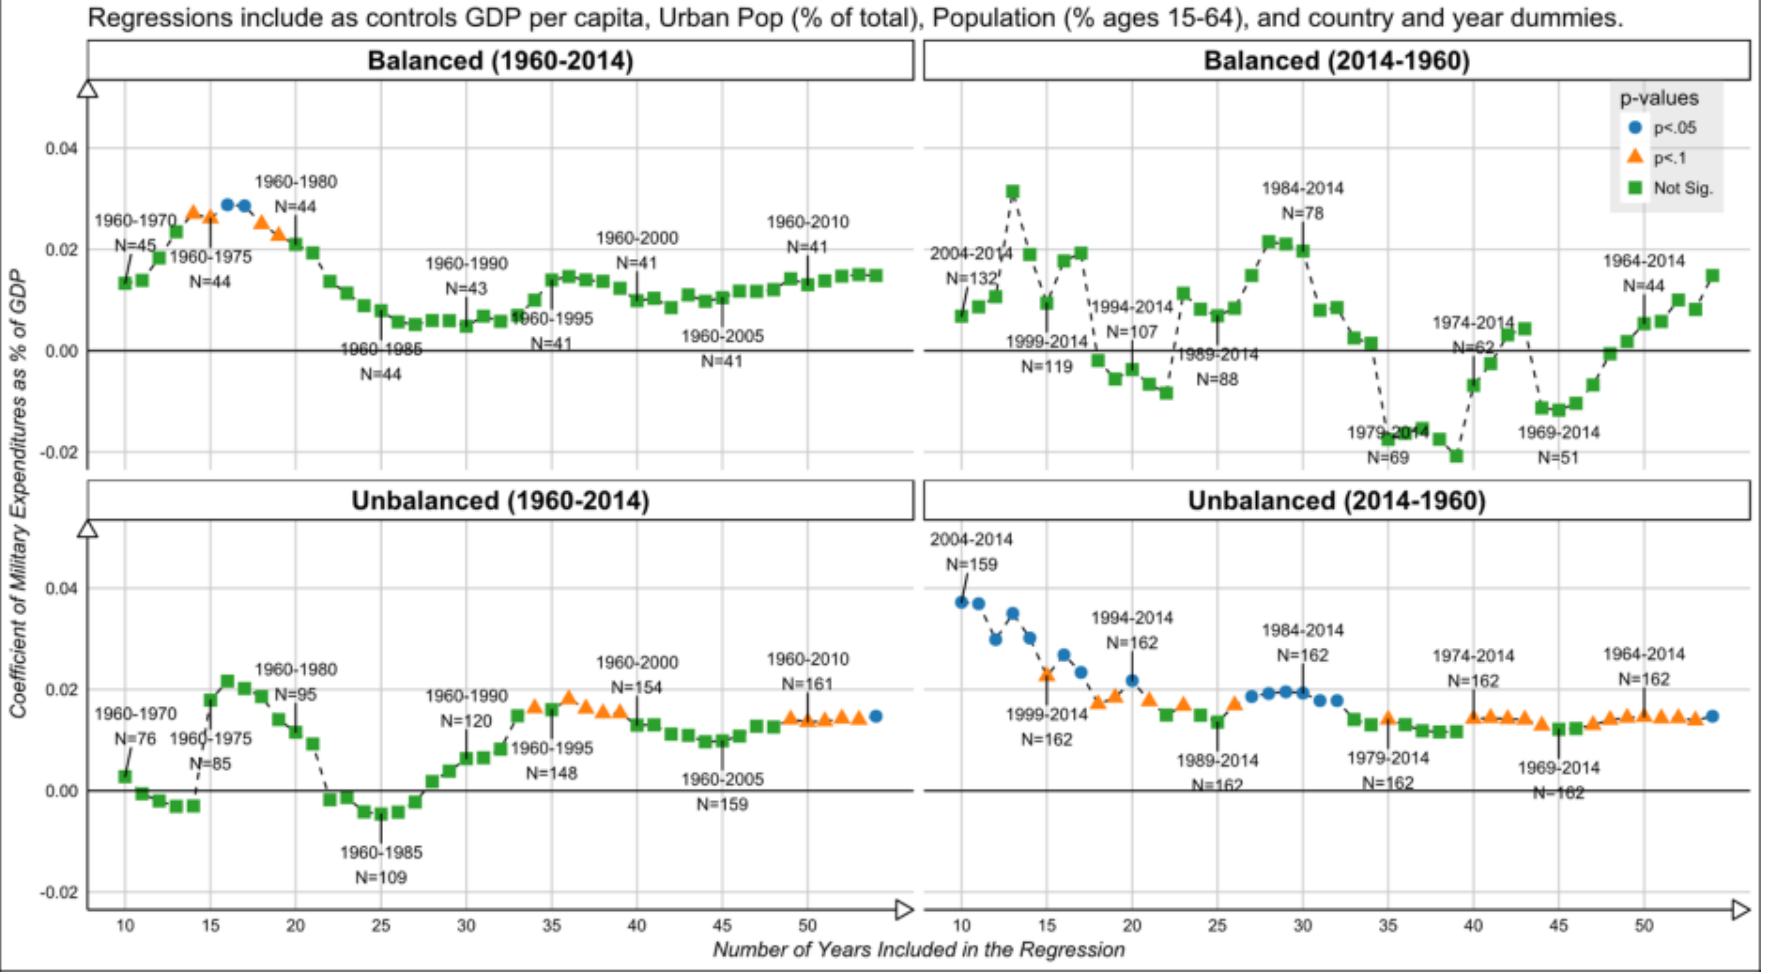
Figure 7. Coefficients of Military Expenditures from Regressions Including Different Years (Two-Way Fixed Effects with AR1